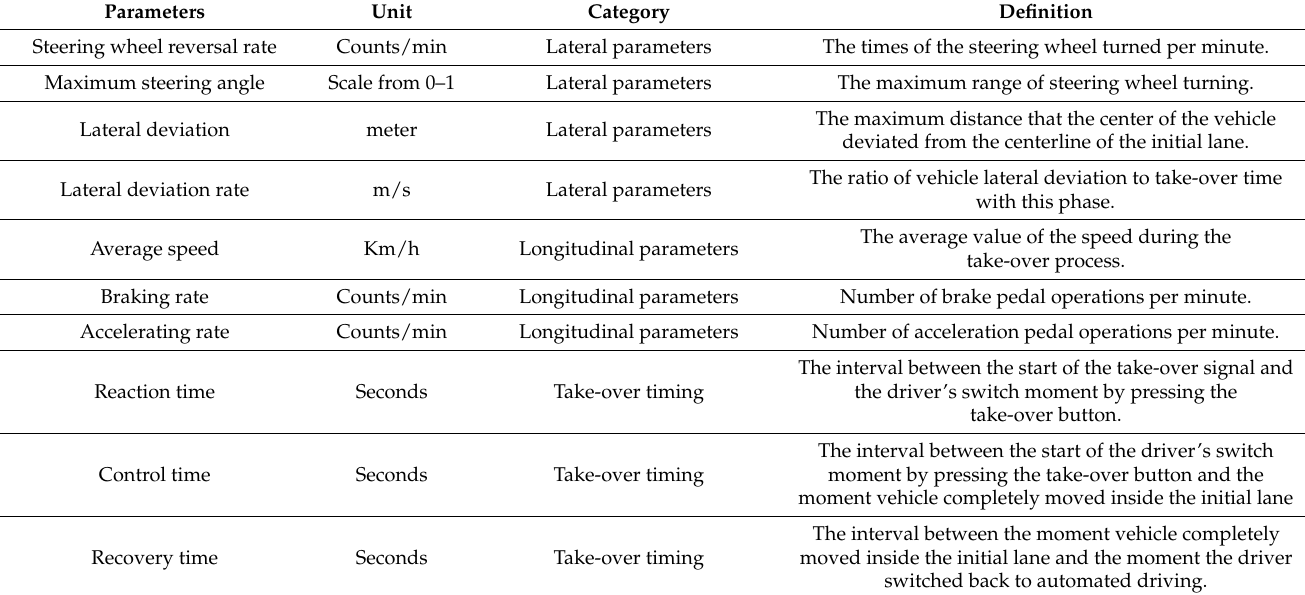
Table 1. Parameter definition